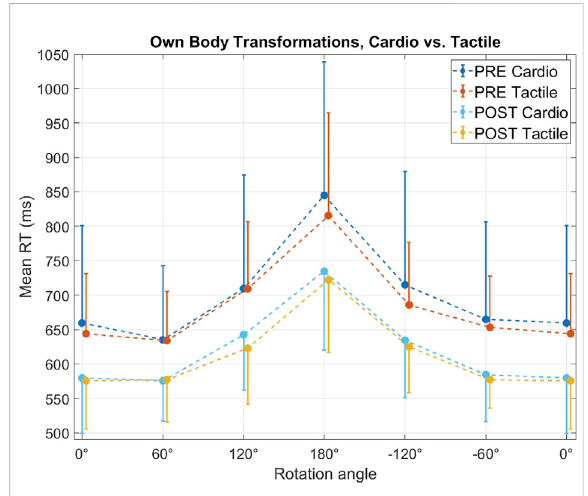
FIGURE 3 Mean response times ( fi lled circles) and SD (vertical bars) during the OBT task measured at different angles before (PRE) and after (POST) the cardio-visual (Cardio) and visuo-tactile (Tactile) stimulations.